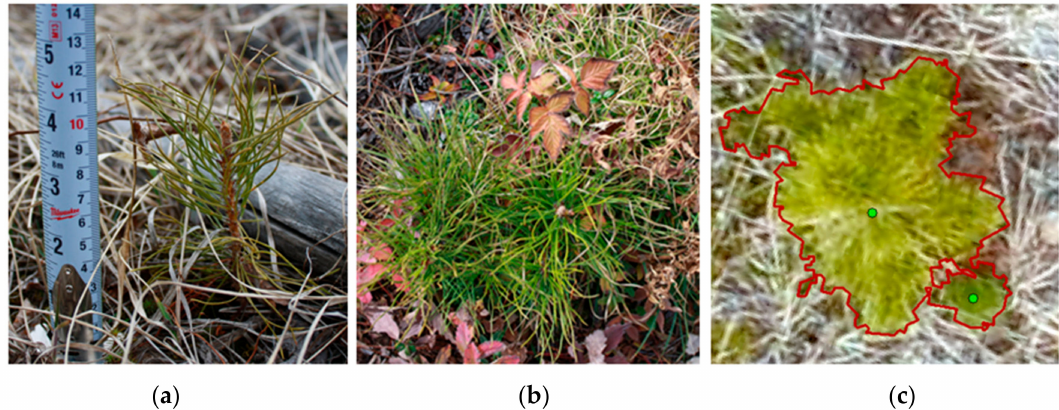
Figure 7. Despite using images with ultra-high spatial resolution, segmentation routines had difficulty detecting very small seedlings ( a ) or delineating groups of seedlings with contiguous crowns ( b ). Normally, individuals within clusters could only be delineated when small gaps occurred between crowns ( c